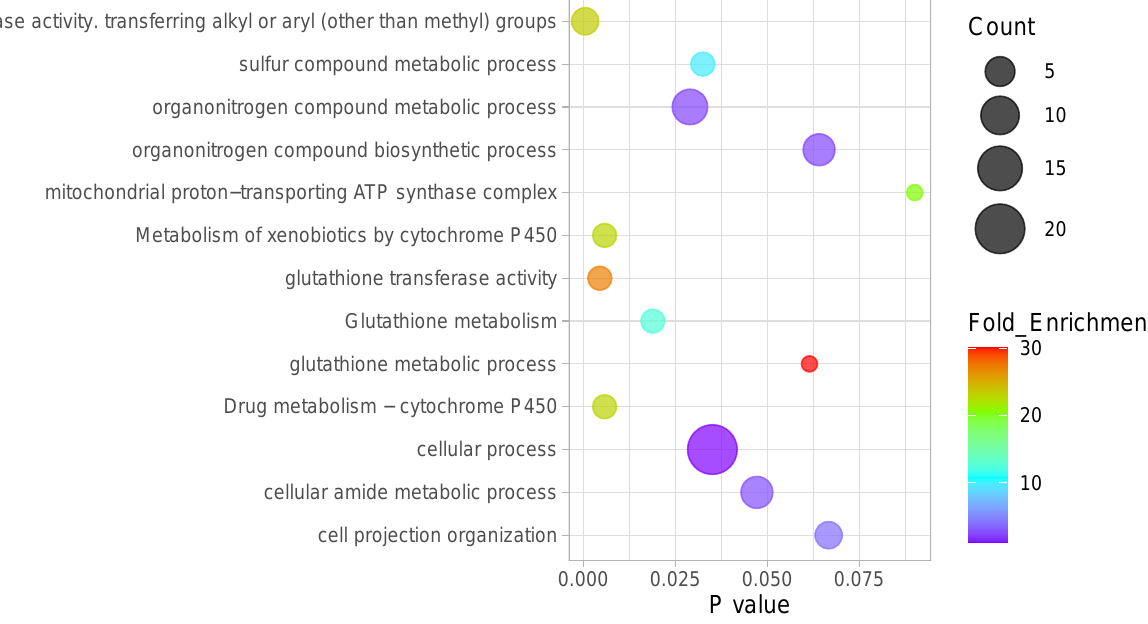
Figure 7. Overrepresented biological process GO terms ( p < 0.10) in the set of genes which were significant only for Latitude in the two-way